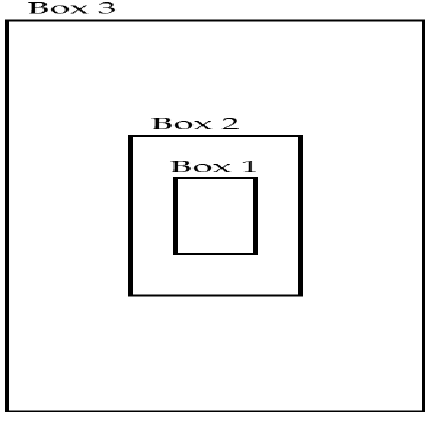
Figure 8. Mean IoU with respect to K for the optimal K determination.